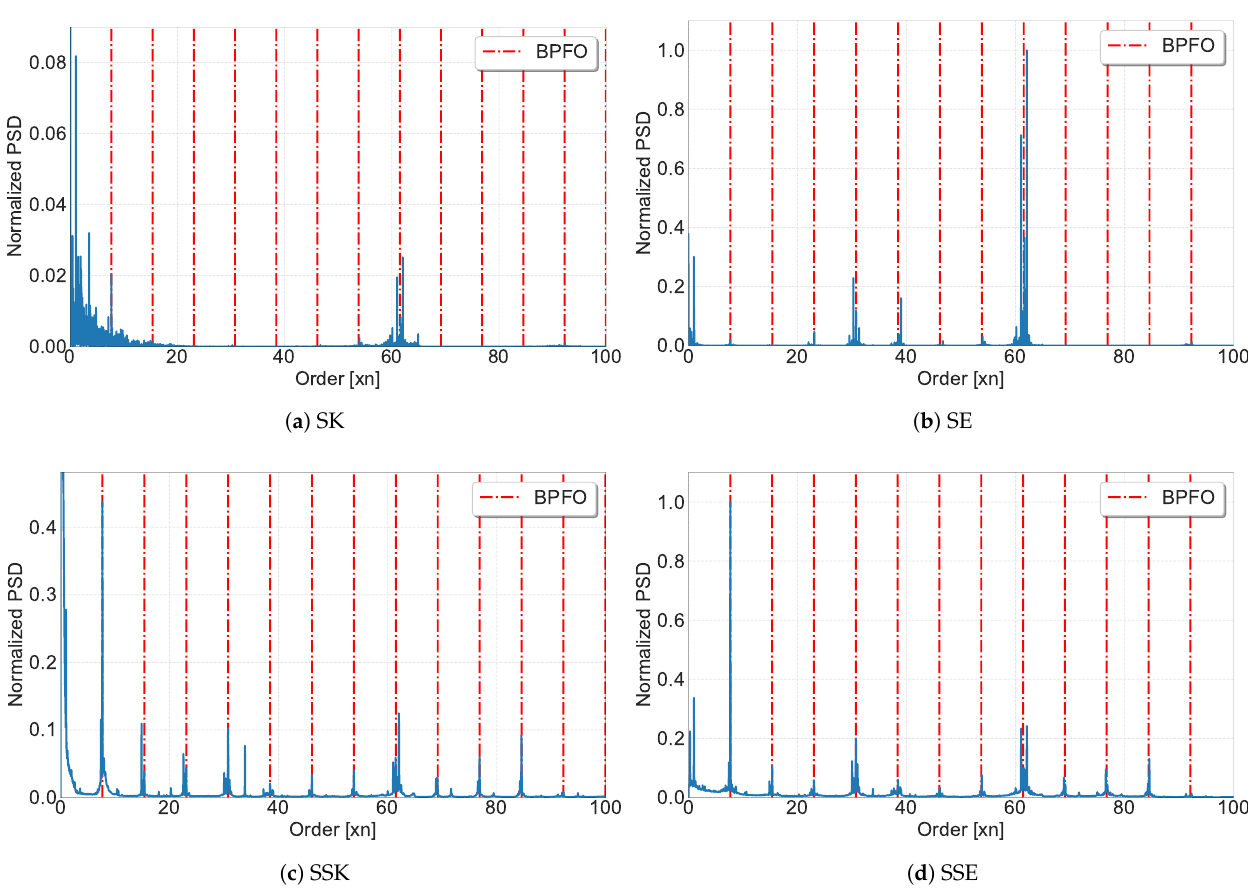
Figure 5. Examples of envelope spectra (obtained from PSD) from aircraft-engine data (SAFRAN). Top row, SK and SE estimators; bottom row, their sliding versions (SSK; SSE).Order represents harmonics of shaft